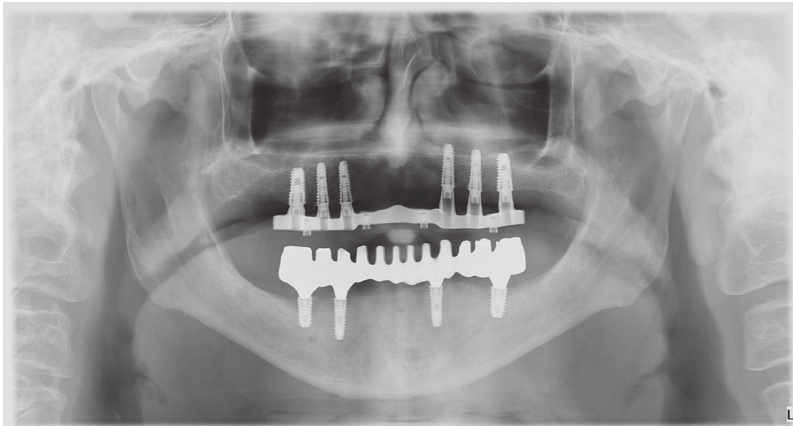
Figure 4: Final panoramic radiograph two years after overdenture delivery.